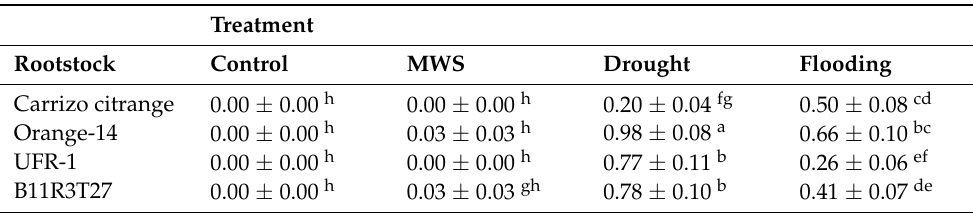
Table 2. Mean standardized area under the abiotic stress progress curve (SAUASPC) during the 30-day of assessment.